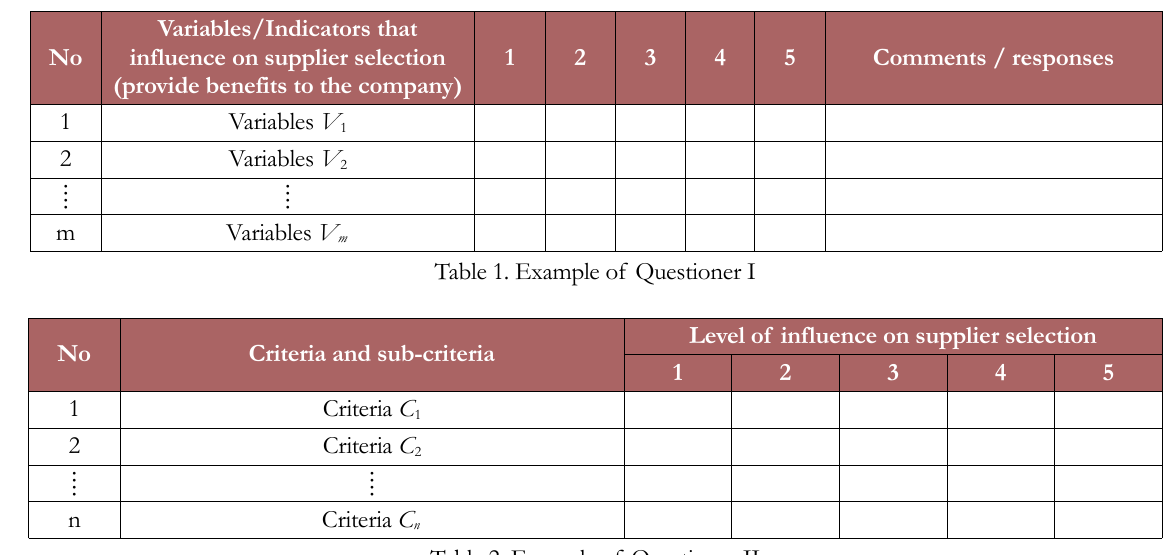
Figure 4. The steps of Delphi